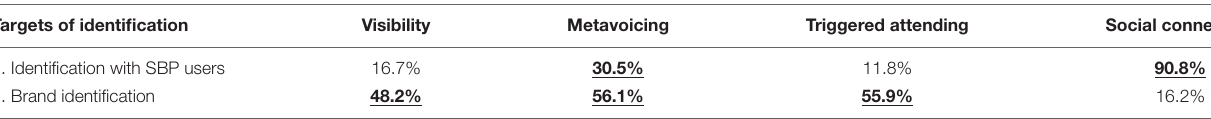
FIGURE 1 | Research model. TABLE 1 | The two identification targets within SBPs and their